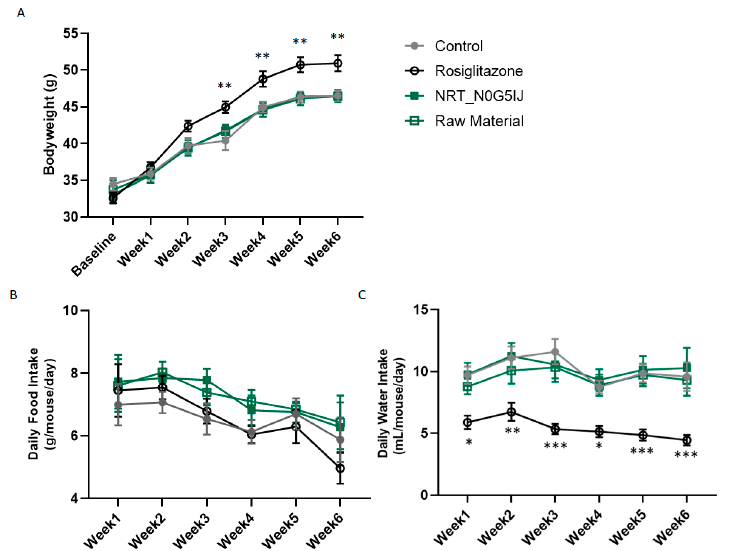
Figure 5. Effect of treatment on body weight, food, and water intake. Measurements of ( A ) body weight, ( B ) food intake, and ( C ) water intake on mice treated with NRT_N0G5IJ (400 mg/kg/day), raw material (400 mg/kg/day), rosiglitazone (15 mg/kg/day), or vehicle by oral gavage. Data are the mean ± SEM and analysed by Dunnett’s multiple comparisons tests as applicable (* p < 0.05, ** p < 0.01, *** p < 0.001; compared to